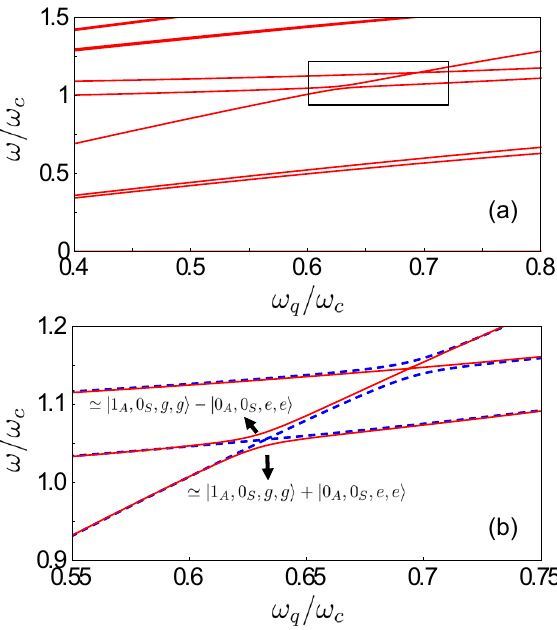
H as a function of the ω i ω 0 for the lowest-energy dressed states of Figure 2. ( a ) Energy differences ω i 0 ˆ = − normalized qubit frequency ω q /ω c (which can be experimentally tuned by changing the external flux bias acting /ω c 0.3 between the qubit and the resonators, g on the qubits). We consider a normalized coupling rate η ≡ | | = 0.05 . The phases for the while the normalized photon hopping rate between the two resonators is J /ω c = π , respectively, and the longitudinal interaction 0 and ϕ 2 cavity–qubit coupling strengths are set to ϕ 1 = = π/ 6 . ( b ) Enlarged view of the inset in ( a ). When coupling term is included by considering a mixing angle θ = π ), the avoided-level crossing (red 0, ϕ 2 the cavity–qubit coupling strengths have opposite phases ( ϕ 1 = = 1 A , 0 S , g , g 0 A , 0 S , e , e solid curves) results from the coupling between the states and due to the presence of | � | � ω A / 2 . The counter-rotating terms in the system Hamiltonian. The energy splitting reaches its minimum at ω q ≃ ω S / 2 indicates that the qubits do not couple 0 A , 1 S , g , g 0 A , 0 S , e , e crossing between the states and at ω q | � ≃ | � with the symmetric normal mode. The complementary result is obtained when the coupling strengths have the ω A / 2 disappears, while the energy spectrum same phase (blue dashed curves). In this case, this splitting at ω q ≃ ω S / 2 , arising from the coherent coupling between the states displays an avoided-level crossing around ω q ≃ 0 A , 1 S , g , g 0 A , 0 S , e , e and | � | �